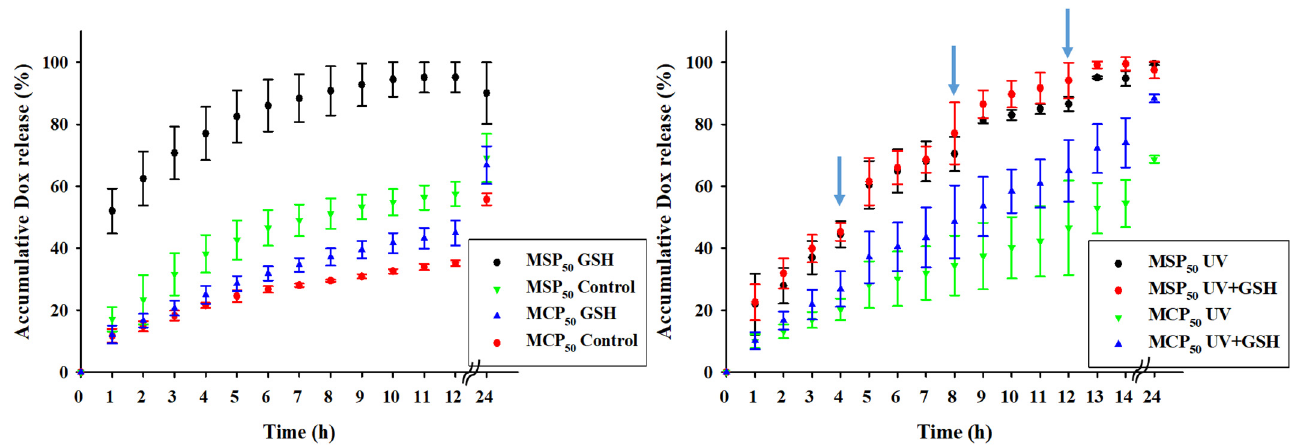
Figure 4. Doxorubicin (DOX) release profiles of DOX-loaded MCP 50 (mPEG-CC-pONBMA) and MSP 50 (mPEG-SS-pONBMA) performed in PBST (PBS+0.2% Tween20) at pH 7.4 and 37 °C under four conditions: without any treatment (control), in the presence of 5 mM glutathione (GSH), under UV irradiation for 7 min, in the presence of 2.5 mM GSH and under UV irradiation for 3.5 min.